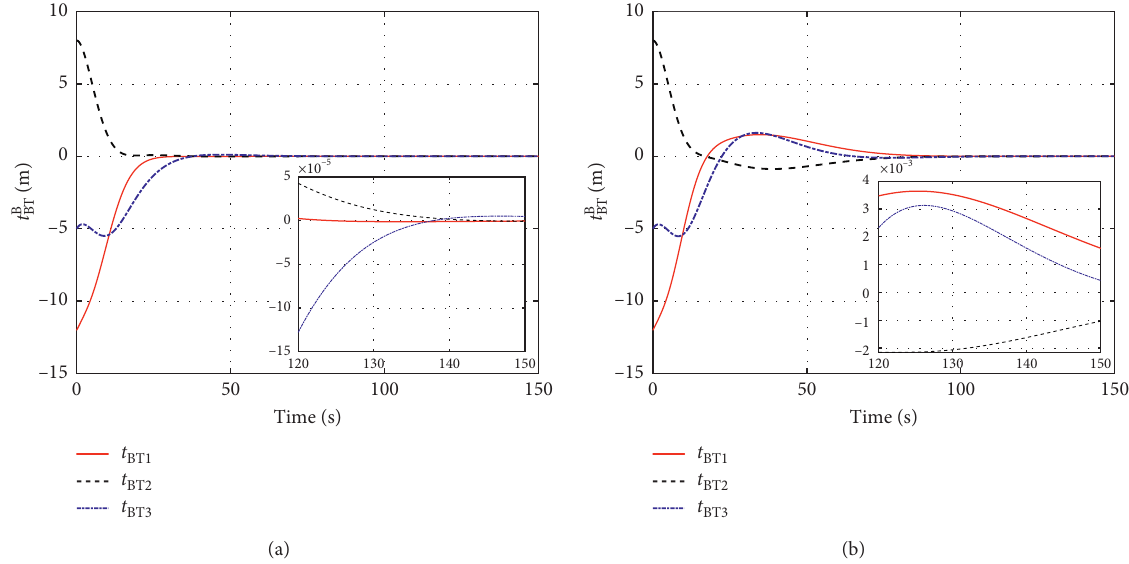
Figure 3: Relative position. (a) Proposed I&I adaptive controller. (b) CE-based adaptive controller.